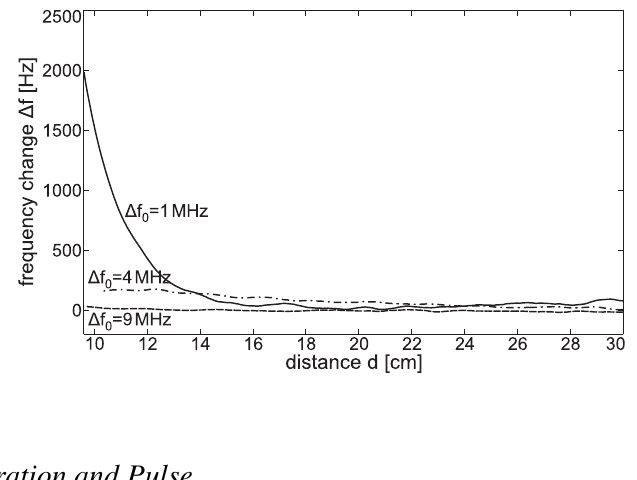
Figure 7. Results of the examination of the mutual interaction between adjacent sensor coils. The distance, d , between two coils is varied by moving one coil along a carriageway towards another one, whose signal output, ∆ f , is plotted. ∆ f coils’ base